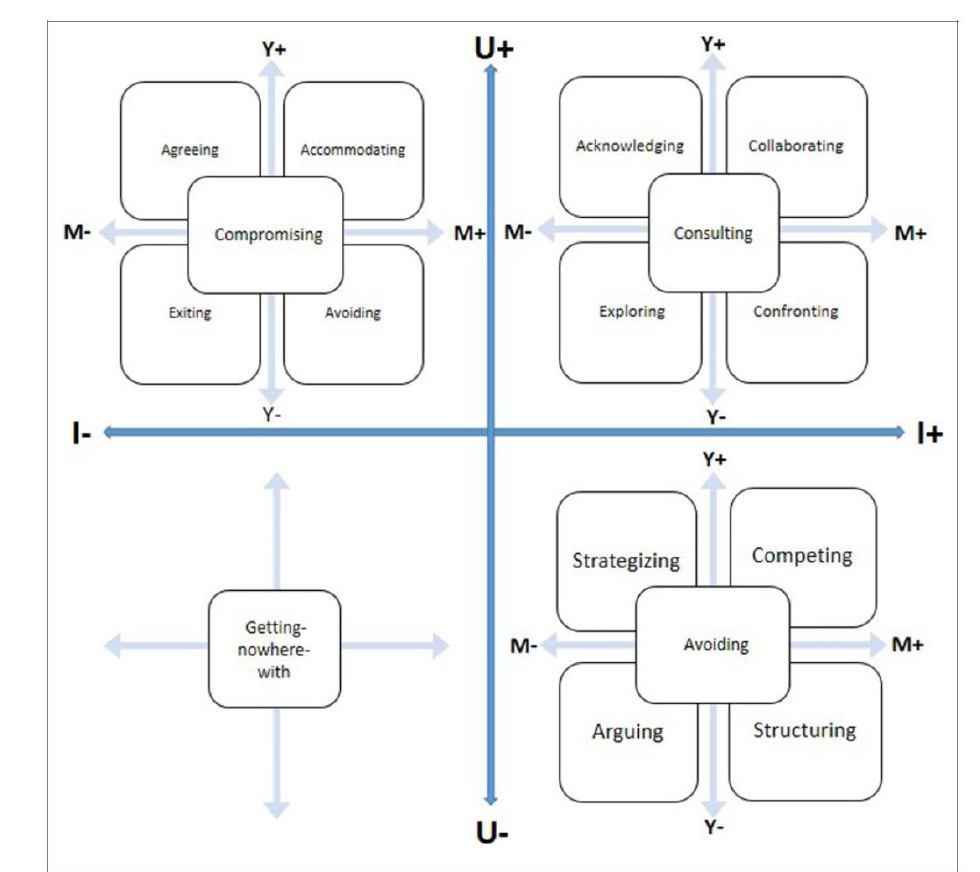
Figure 20: Conflict Strategies: Process (Suriyaprakash & George, 2015,